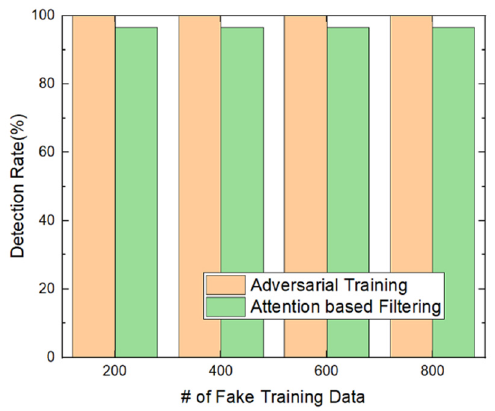
Figure 12. Detection Rate Comparison.